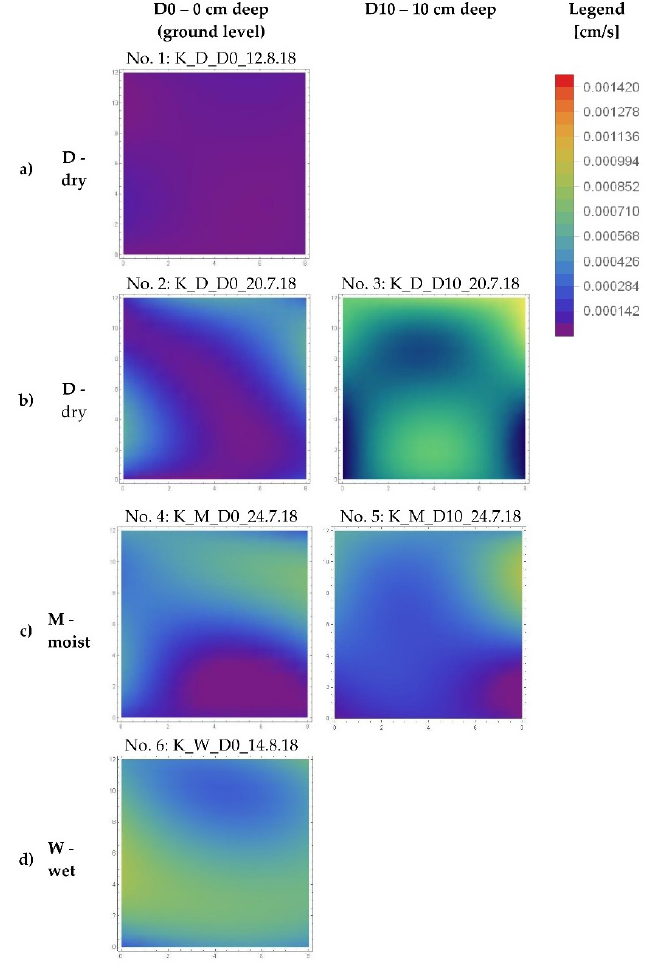
Water 2019 , 11 , x FOR PEER REVIEW Figure 6. Results of MDI measurements presented using heat maps. Figure 6. Results of MDI measurements presented using heat maps.